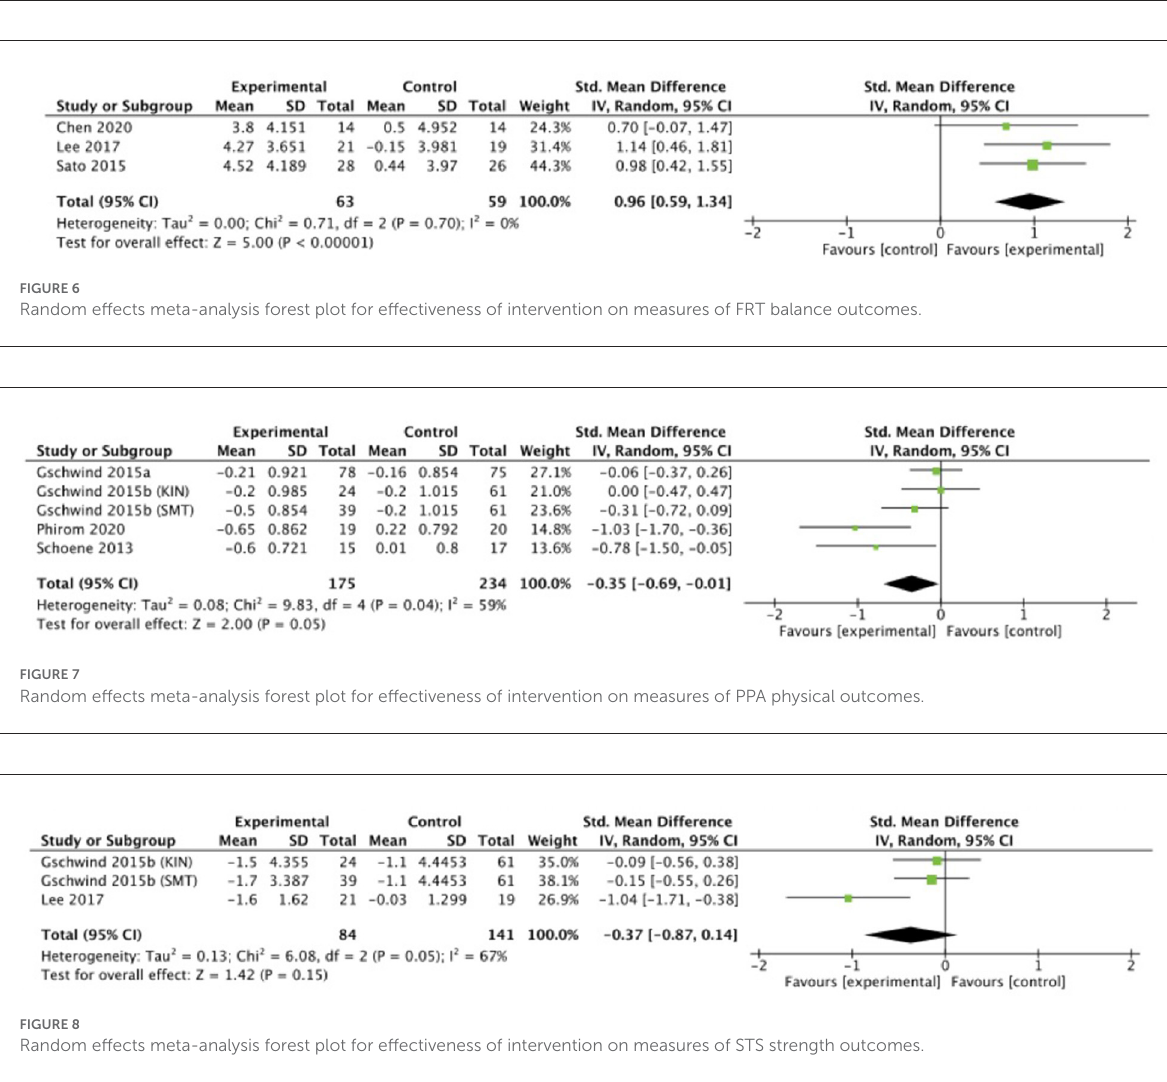
exercise intervention group consisted of 74 participants